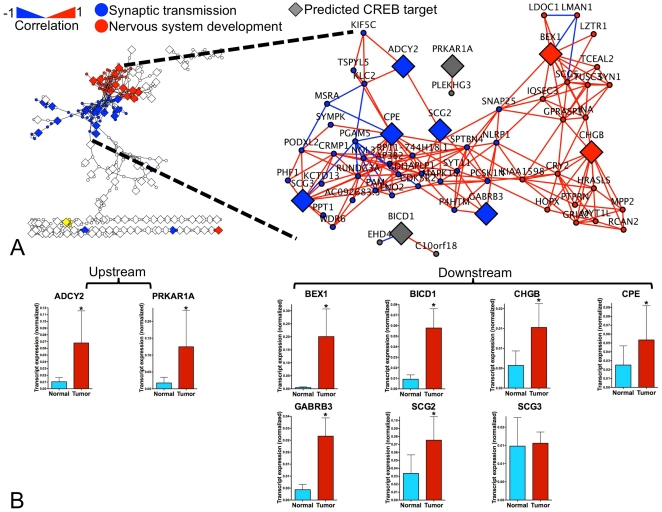

ADCY2, PRKAR1A, and CREB response elements expression examined by Real-time PCR.
2A) Identification of putative CREB response elements in the SI NET interactome. 2B) Transcripts of ADCY2, cAMP synthetase, and PRKAR1A, a key member of the PKA, were up-regulated in KRJ-I, (700% and 722% respectively, p<0.02 compared to normal). Six of 7 CRE transcripts were confirmed to be over-expressed in SI NETs (p<0.05) with the exception of SCG3 (p = 0.24). MEAN±SEM (nTumor = 10, nNormal = 8).